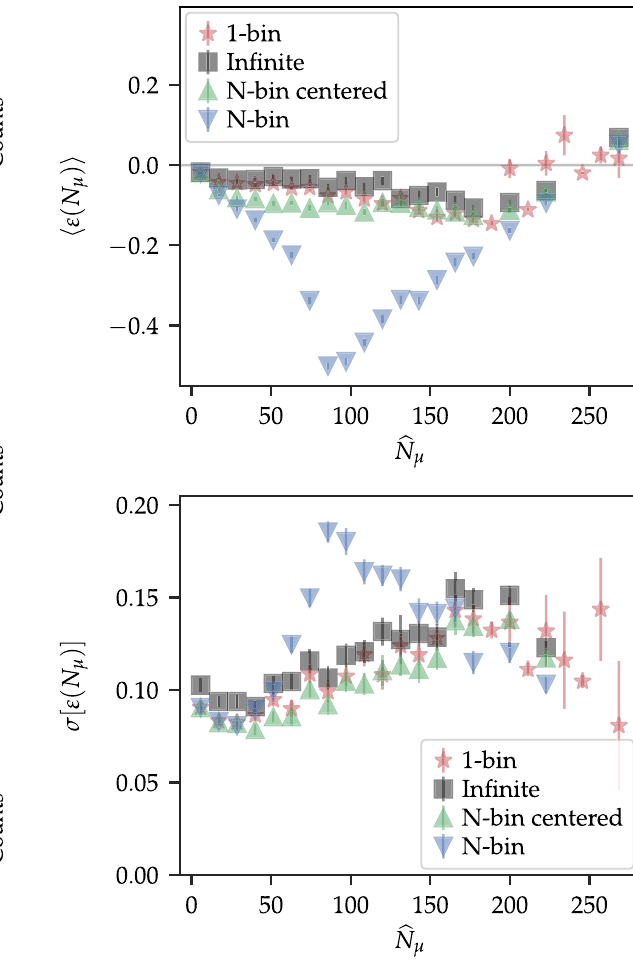
Fig. 10 Same as Fig. 8 but with the estimated number of muons in the